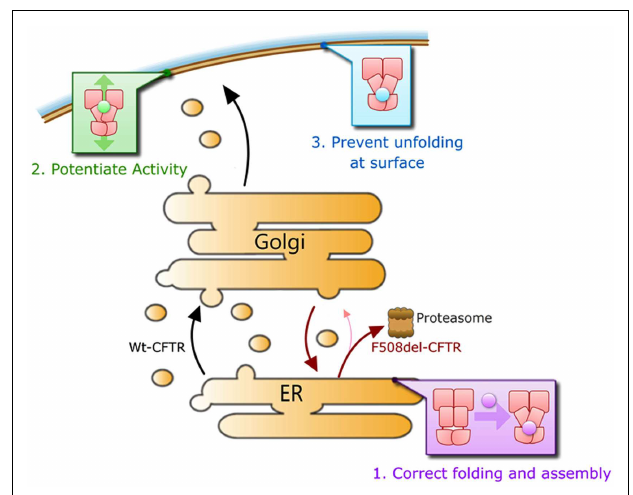
FIGURE 4 | Overview of molecular defects requiring repair for functional rescue of F508del-CFTR. of residence time ( Figure 4 ). A defect in any one of these steps would lead to